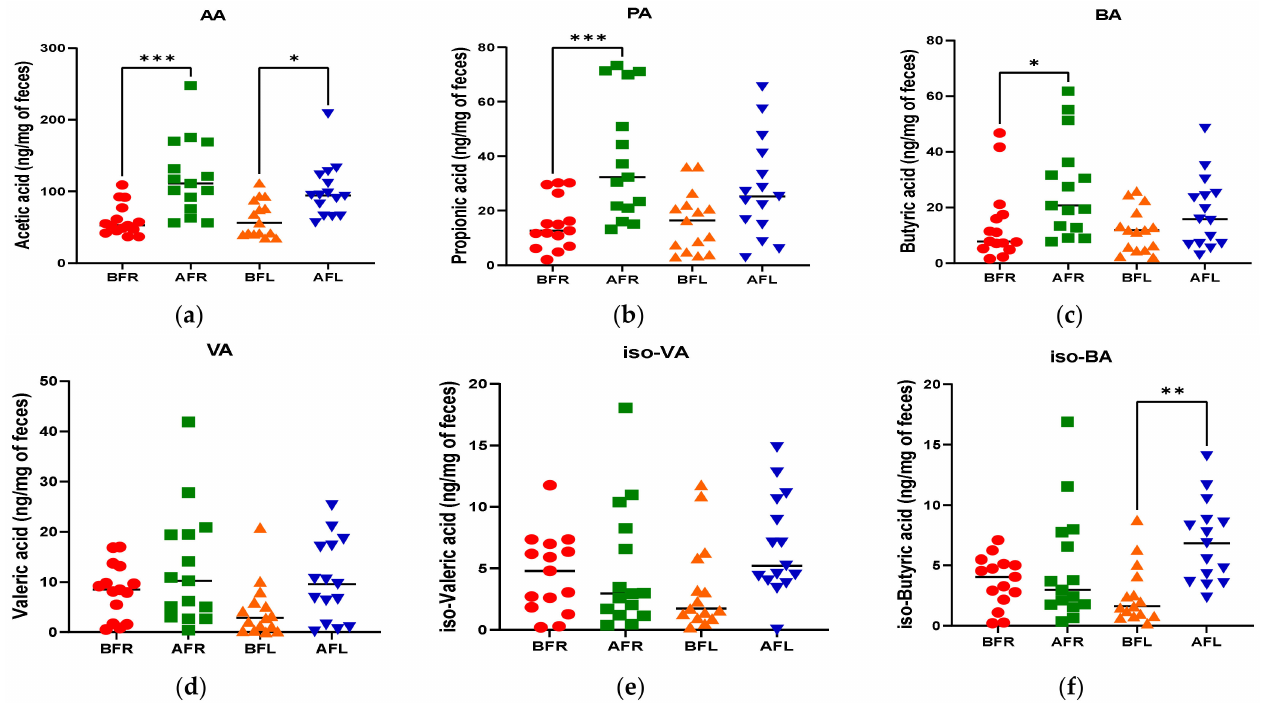
Figure 4. Differences between flavonoid-rich orange juice group or flavonoid-low orange cordial group in short-chain fatty acids (SCFAs) from before and after intervention with flavonoid-rich (BFR & AFR) or flavonoid-low (BFL & AFL) orange juice. AA: acetic acid ( a ), PA: propionic acid ( b ), BA: butyric acid ( c ), VA: valeric acid ( d ), iso-VA: iso-valeric acid ( e ), iso-BA: iso-butyric acid ( f ). BFR: Before flavonoid-rich orange juice group, AFR: after flavonoid-rich orange juice group, BFL: before flavonoid-low orange cordial group, AFL: after flavonoid-low orange cordial group. * p < 0.05; ** p < 0.01; *** p <